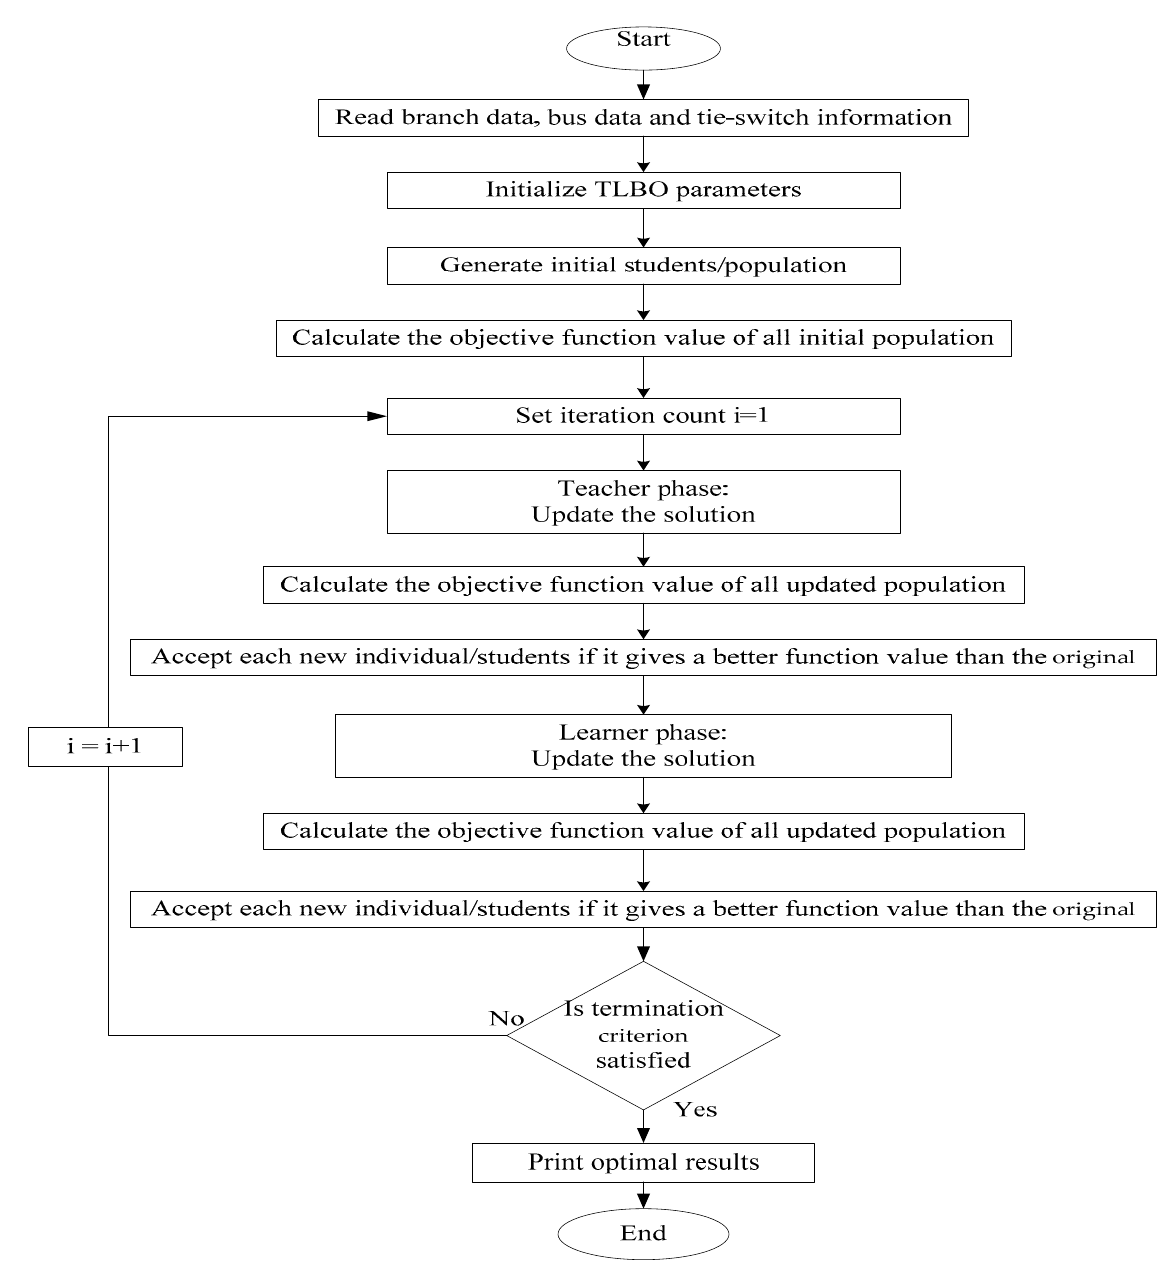
Figure 2. TLBO algorithms for radial distribution network service restoration.